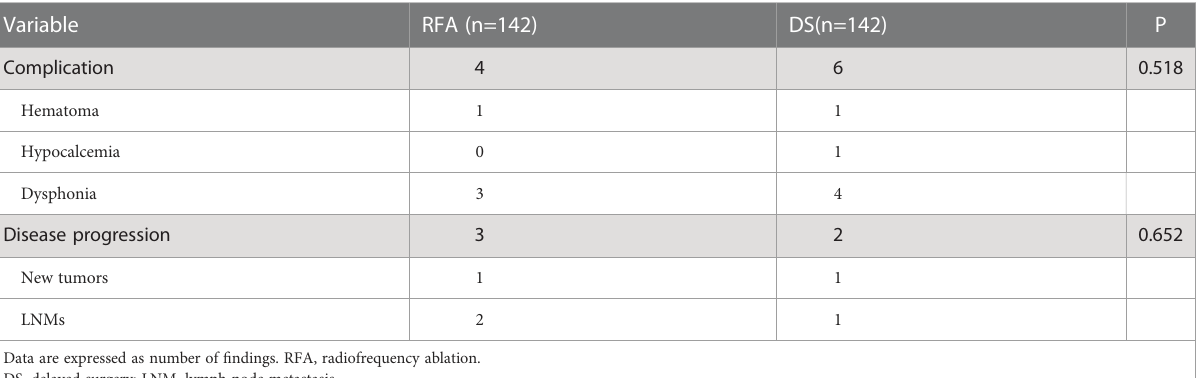
TABLE 4 The complications and disease progression of RFA and DS.